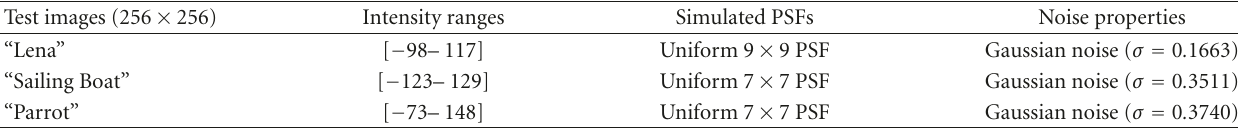
Table 1: Image and degradation information for the three test images.